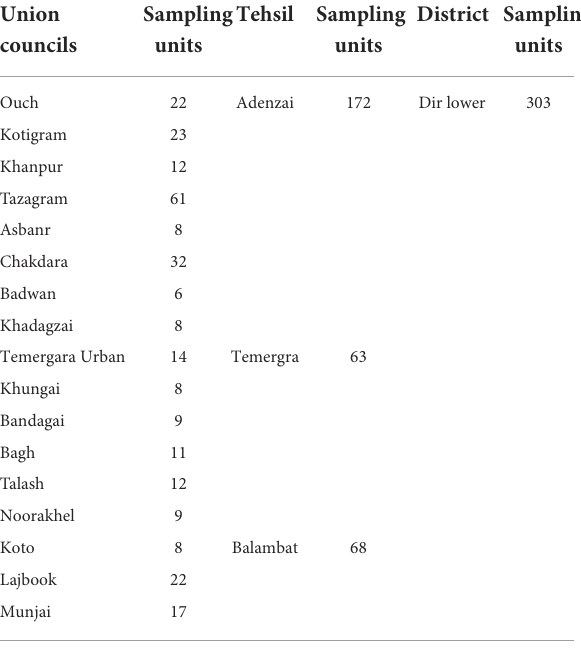
TABLE 1 Union council-wise distribution of the sample units. Union Sampling councils units units